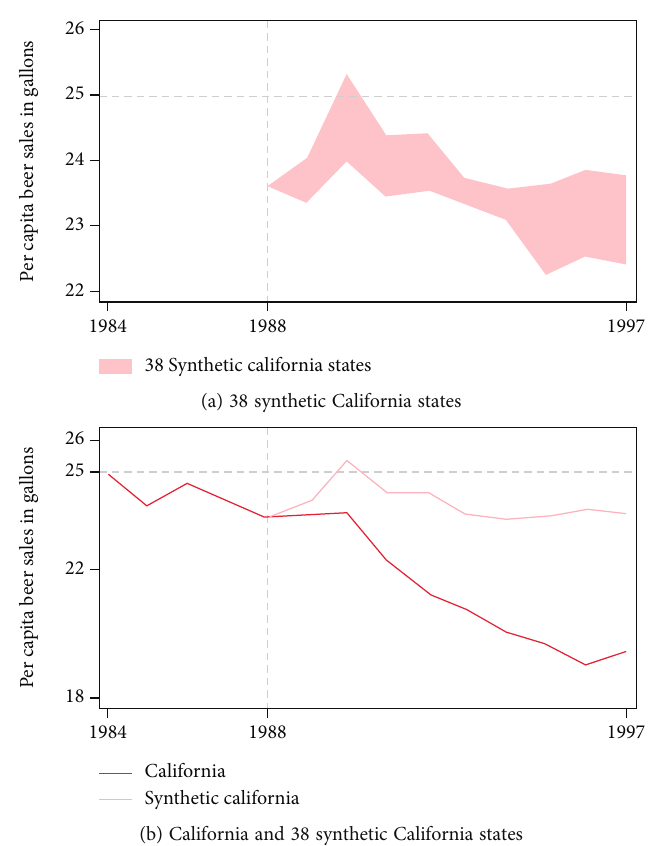
Figure 3: The results from the leave-one-state-out